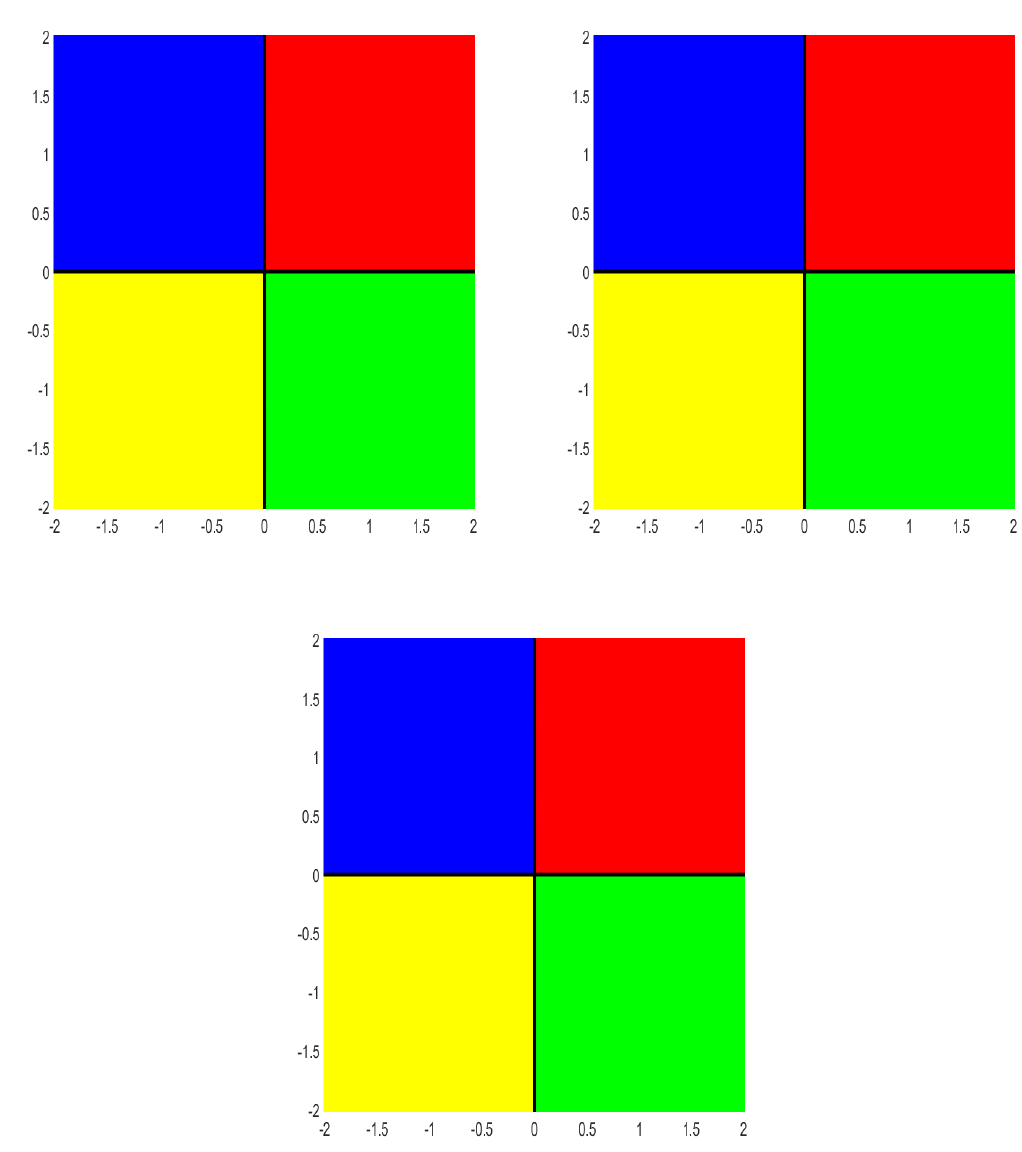
Figure 3. Dynamics of (2), (3) and (4), respectively, with BA, for Example